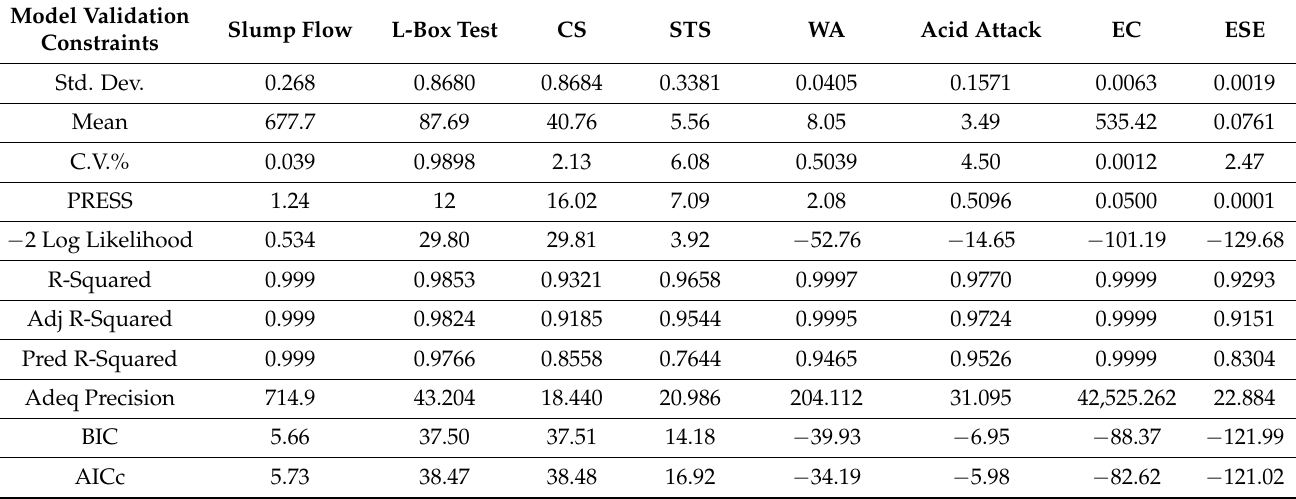
Table 3. Statistical checks for RSM model precision and reliability.